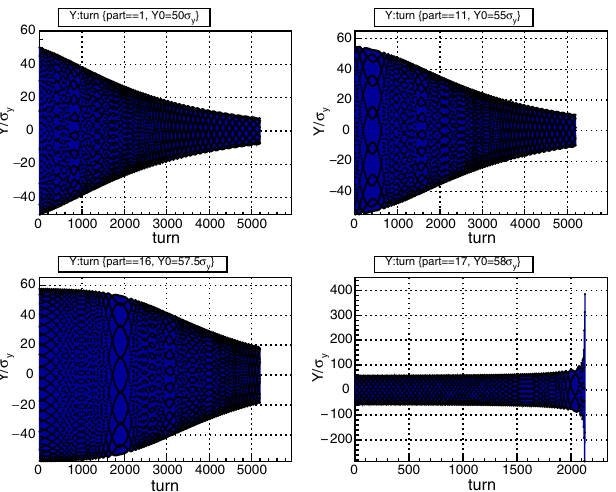
FIG. 4. Time evolution of vertical oscillations for particles with initial vertical coordinate y ¼ f 50; 55; 57 . 5; 58 g × σ coordinates are zero, longitudinal are adjusted for synchronous